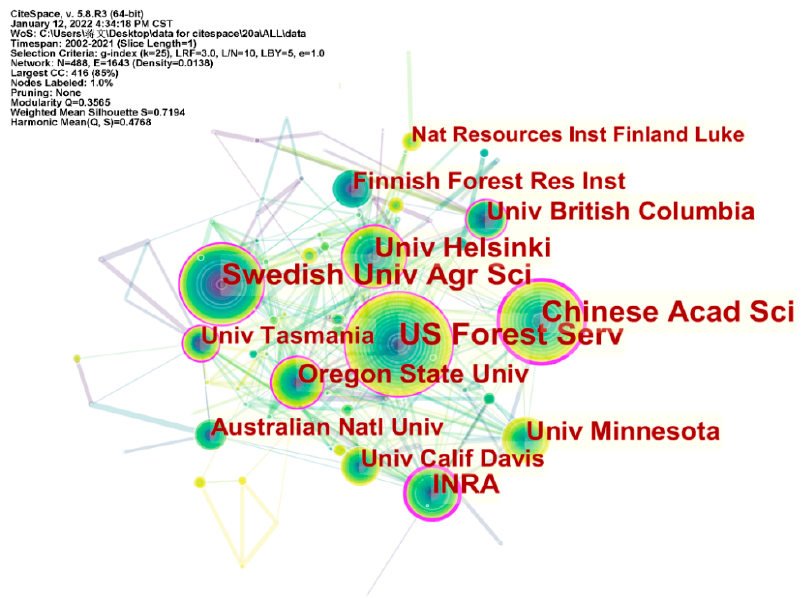
Figure 7. The network of institutional